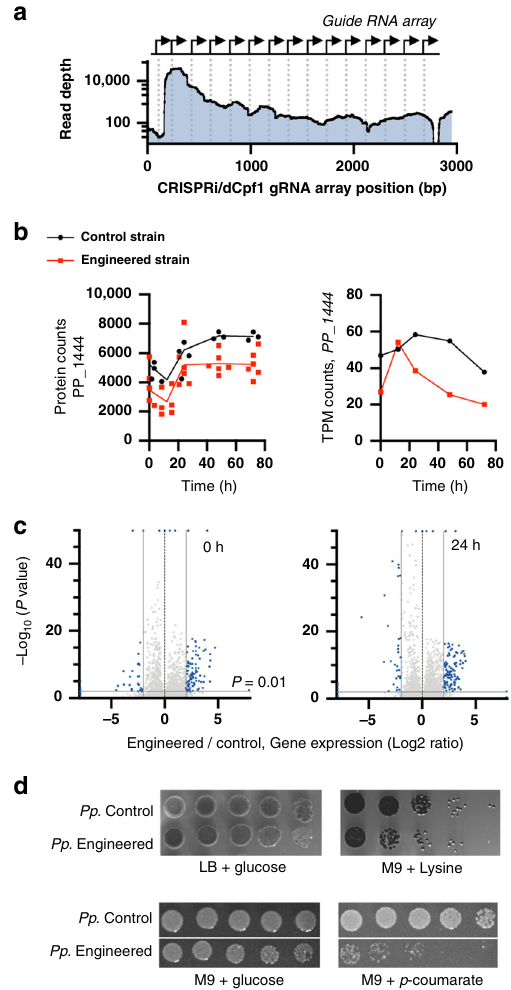
Fig. 2 Characterization of the multi-gene engineered strain via RNAseq and proteomics. a – c P. putida harboring a genomically integrated indigoidine expression cassette and either an empty vector (control strain) or a dCpf1/CRISPRi targeting array examined for gene knockdown ef fi ciency. a RNAseq analysis of plasmid-borne gRNA array targeting 14 genes (Fig. 1a, and Supplementary Data 1) in P. putida . b Knockdown ef fi ciency of a representative gene locus PP_1444 ( gcd ) targeted for inhibition over a 72-h time course. RNA expression levels (right hand panel) were validated with targeted proteomic analysis (left hand panel). Proteomic samples were analyzed with n = 3 for control samples and n = 6 for the engineered strain. For the RNAseq analysis for the control sample and n = 2, n = 4 for the engineered strain. For the proteomics sample, all data points are shown. Transcripts per kilobase million (TPM) counts from a representative RNAseq time course are shown. c dCpf1/CRISPR interference causes global RNA expression level changes. Volcano plot of mRNA expression levels compared at t = 0 h and t = 24 h between multi- gene engineered and control strains. 184 data points (0 h) and 391 data points (24 h) out of 5369 data points are outliers some are displayed on the edge of the axes. The y -axis indicates the expression value of log 10 ( q - value), and the x -axis displays the log 2 fold change. The blue dots represent gene expression levels that were signi fi cantly different, and the dotted blue line indicates the threshold where P = 0.01. P -values were calculated using Fisher ’ s exact test. Gray dots indicate transcripts that were not statistically signi fi cant. d Validation of carbon source rewiring. Genome-scale modeling predicts that glucose/indigoidine rewiring blocks growth of engineered strains on lysine or para -coumarate as a carbon source. A representative set of plates is shown from three biologically independent experiments. Source data are provided as a Source Data fi